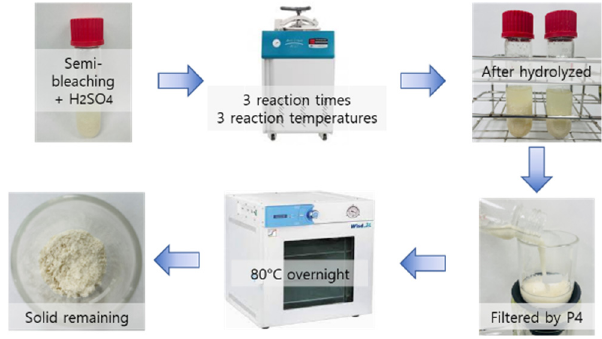
Figure 1. Illustration of acid hydrolysis treatment process.